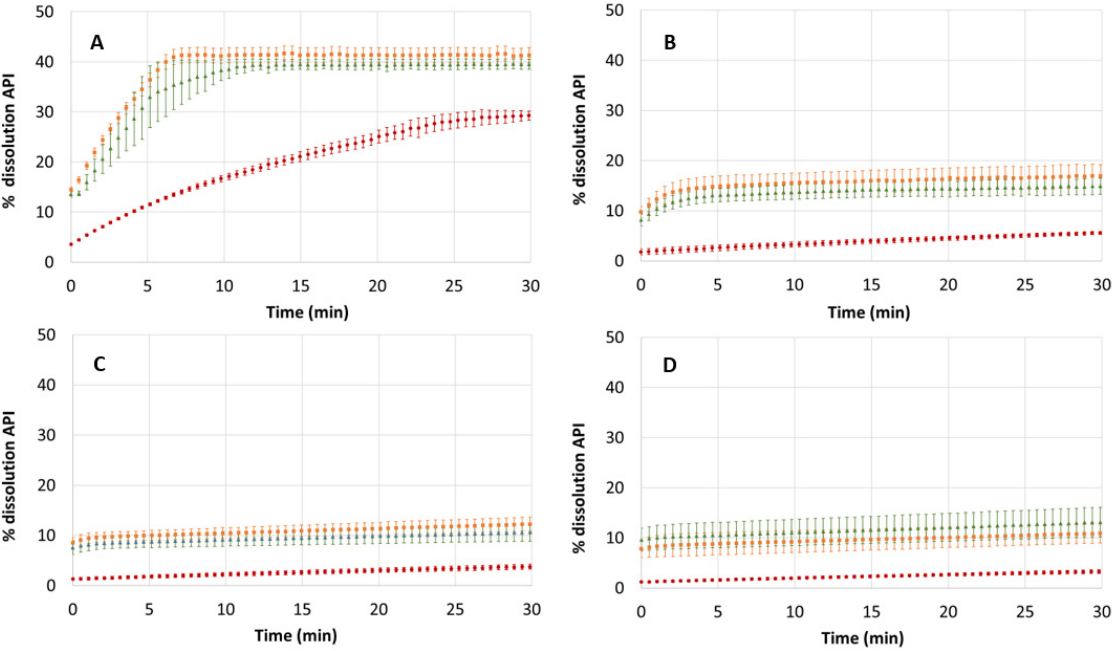
Figure 7. Dissolution profiles of AD (•), AD–Res cocrystal (Form I) (•) and AD–Orc cocrystal (•) at different pH values: pH 1.5 ( A ); pH 4.0 ( B ); pH 5.5 ( C ) and pH 7.4 ( D ). Table 3. Percentage of dissolution and dissolution rate (nmols min − 1 ) of AD and the cocrystals at different GIT pH values. AD solubility ( μ M) and the solid forms observed in the tablet surface after the dissolution measurements are also provided. Standard deviation is shown in parenthesis ( n =·3).